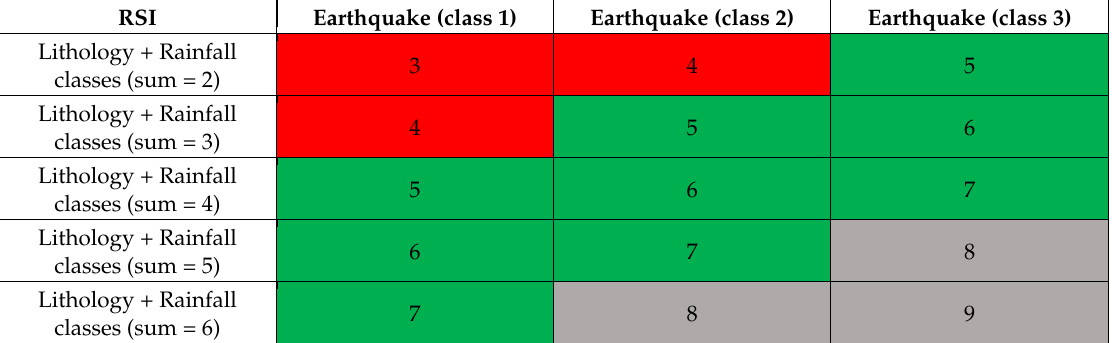
Table 6. Rating matrix for the calculation of Rockfall Susceptibility Index (RSI). Category of low susceptibility in grey, moderate in green, and high in red.